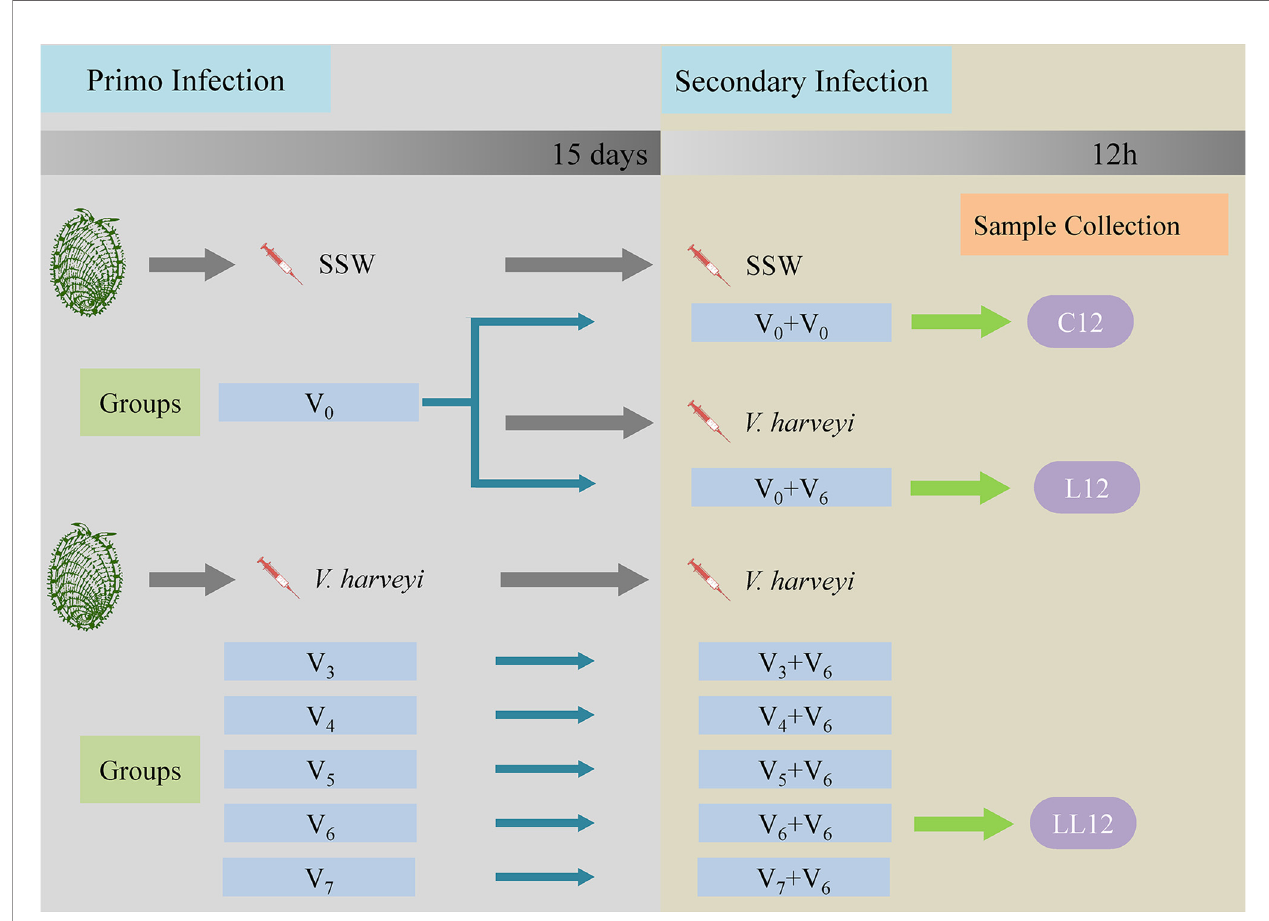
FIGURE 1 | Schematic diagram of the experimental design. Each experiment consisted of two successive infection challenges. For the primary immune challenge, abalone from the same batch were injected with either sterile sea water (SSW, group V 0 ) or different concentrations of V. harveyi : 1.42 × 10 3 CFU mL -1 , 1.42 × 10 4 CFU mL -1 , 1.42 × 10 5 CFU mL -1 , 1.42 × 10 6 CFU mL -1 and 1.42 × 10 7 CFU mL -1 , designated as V 3 , V 4 , V 5 , V 6 and V 7 , respectively. Fifteen days later, the fi ve treatment groups and the V 0 group received an injection of V. harveyi at a concentration of 1.58 × 10 6 CFU mL -1 (designated as V 3 + 6 , V 4 + 6 , V 5 + 6 , V 6 + 6 V 7 + 6 and V 0 + 6 ). The V 0 group was also injected with SSW as a control for the secondary infection (V 0 + 0 ). During each experimental infection, mortalities were monitored daily post-challenge. The abalone hepatopancreases were sampled 12 h after the second stimulation in the V 0 + 0 , V 0 + 6 and V 6 + 6 groups, and named C12, L12 and LL12 groups, respectively. Gene expression levels in the hepatopancreas were then analyzed by